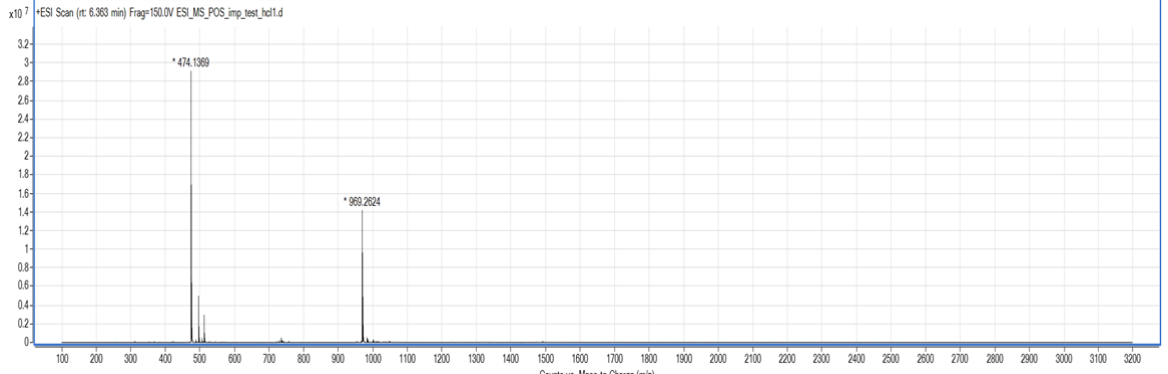
Fig. 5. Mass spectrum of the triazoprazole basic